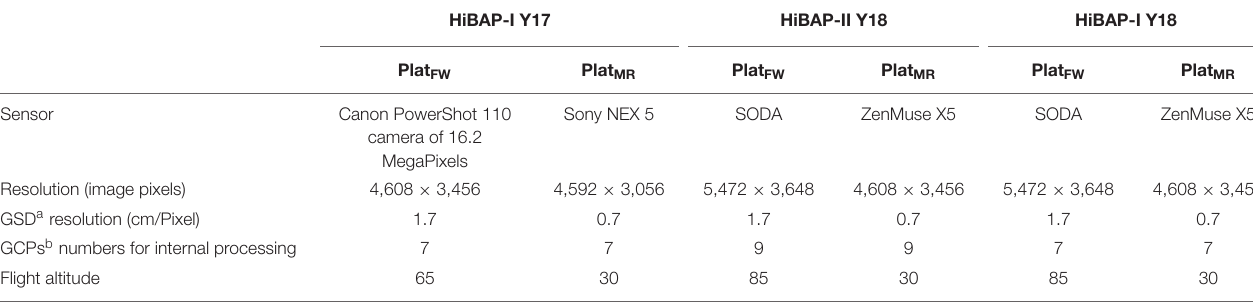
TABLE 3 | Parameters of flight specifications details for fixed-wind ( Plat FW ) and multi-rotor ( Plat MR )